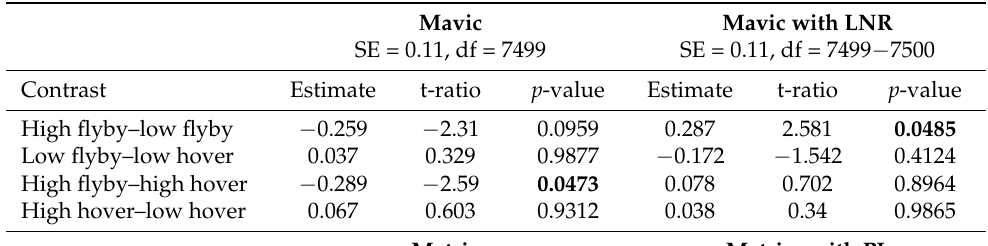
Table A3. Pairwise contrasts of distraction scores for each UAV. p -values in bold represent statistical significance (<0.05).